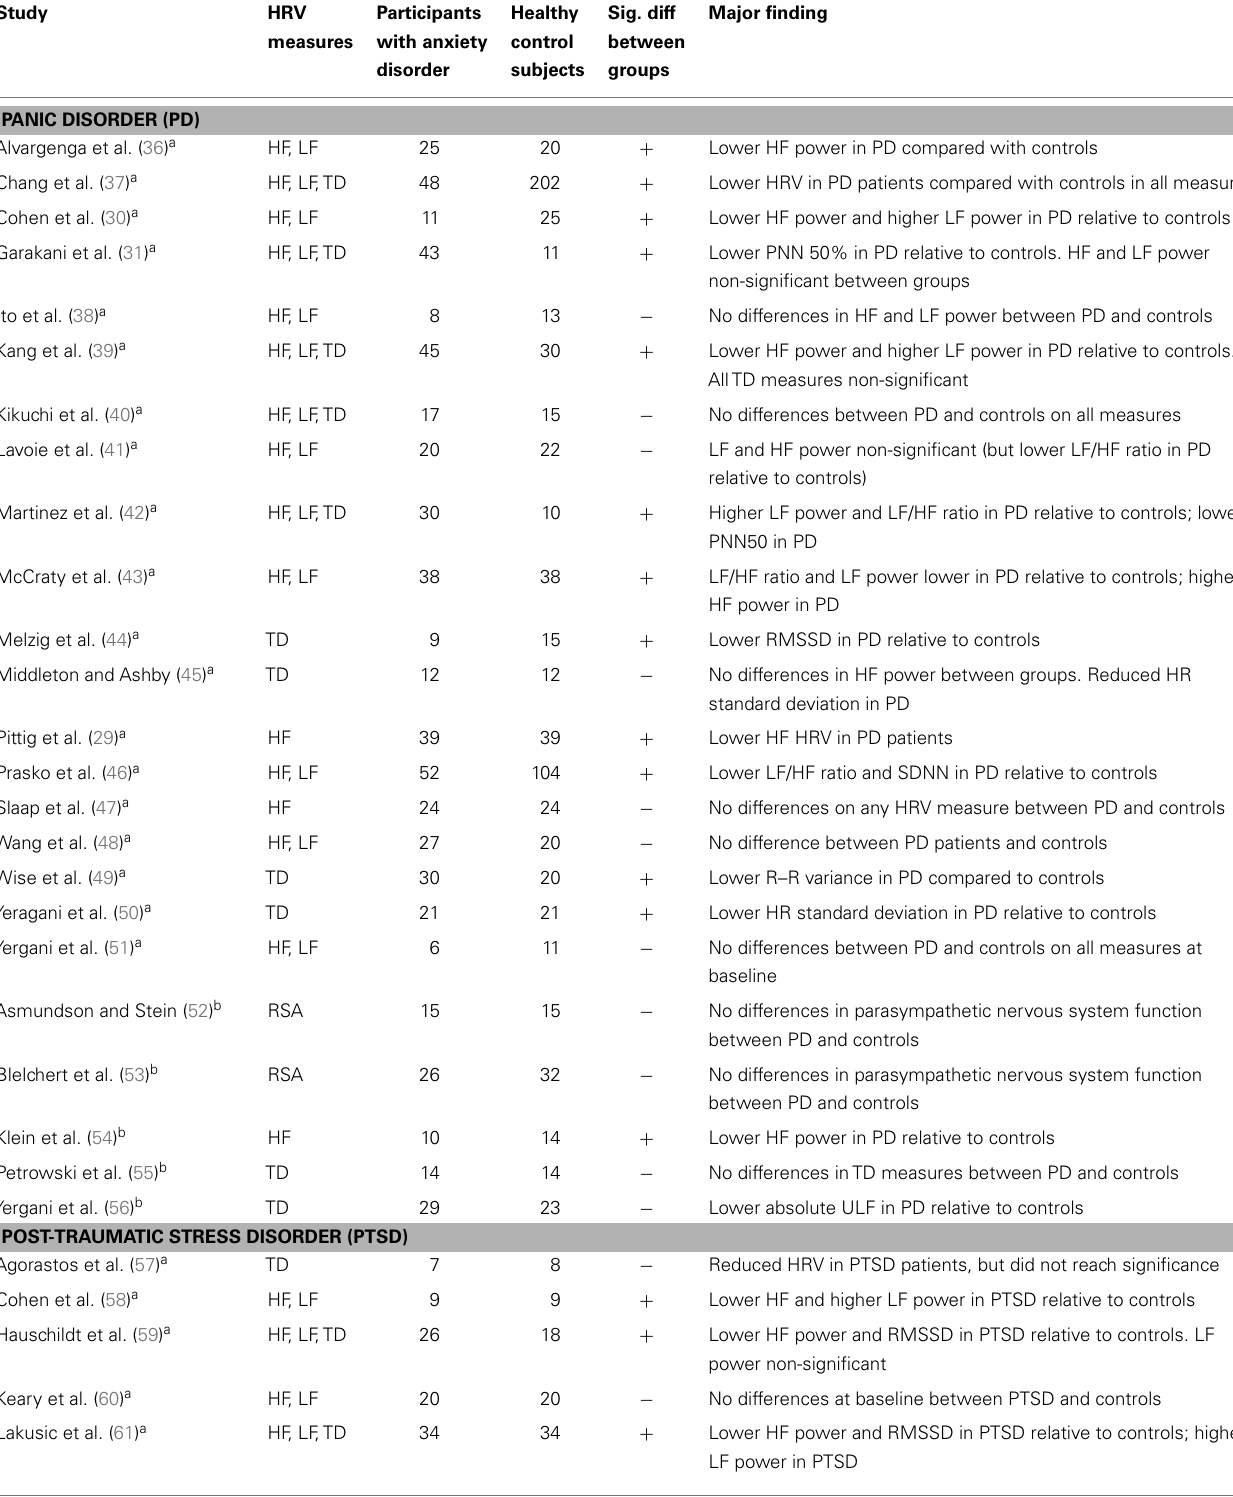
Table 1 | Summary of studies reporting comparisons in HRV between patients with anxiety disorders and controls .